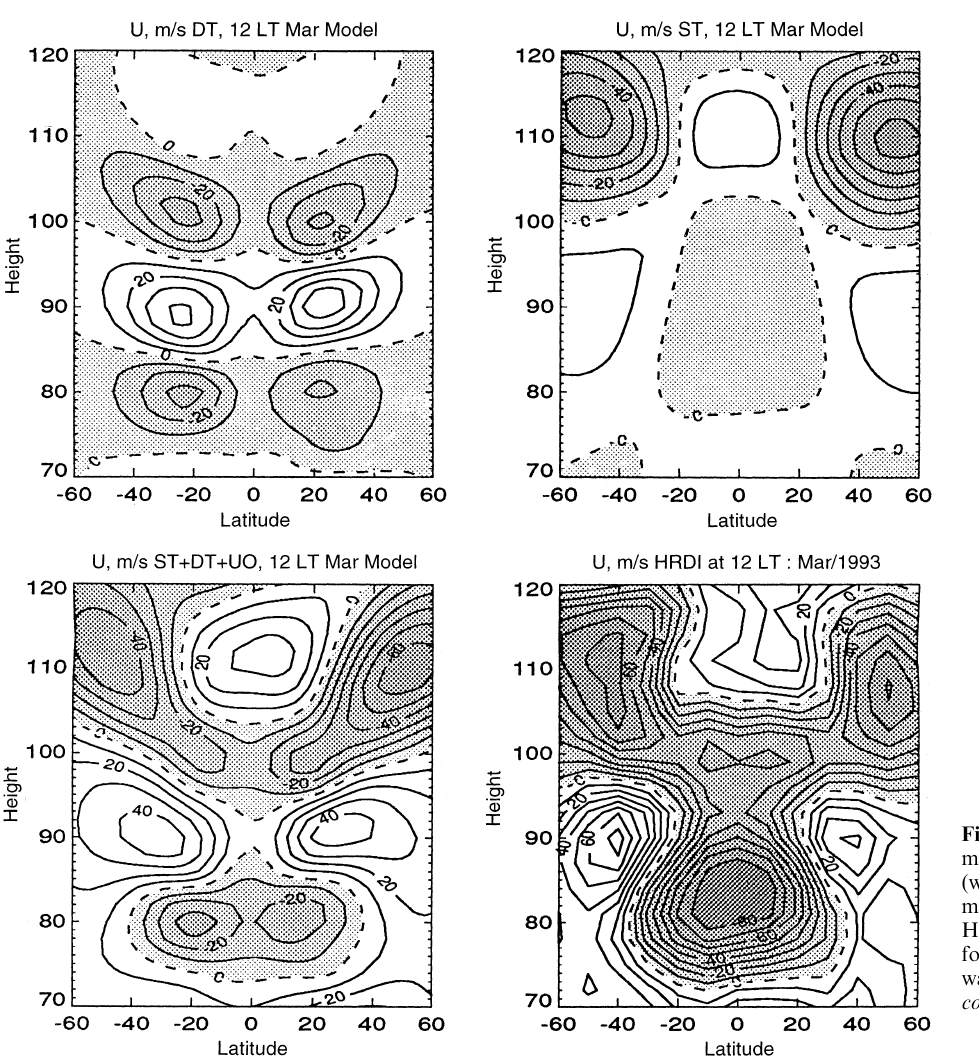
Fig. 2. Zonal winds predicted by mechanistic tidal model results (without tuning), HWM-93 zonal mean wind for March, and HRDI zonal wind observations for March 1993 at 12 LT. West- ward winds are shaded ; dashed contour is the zero wind